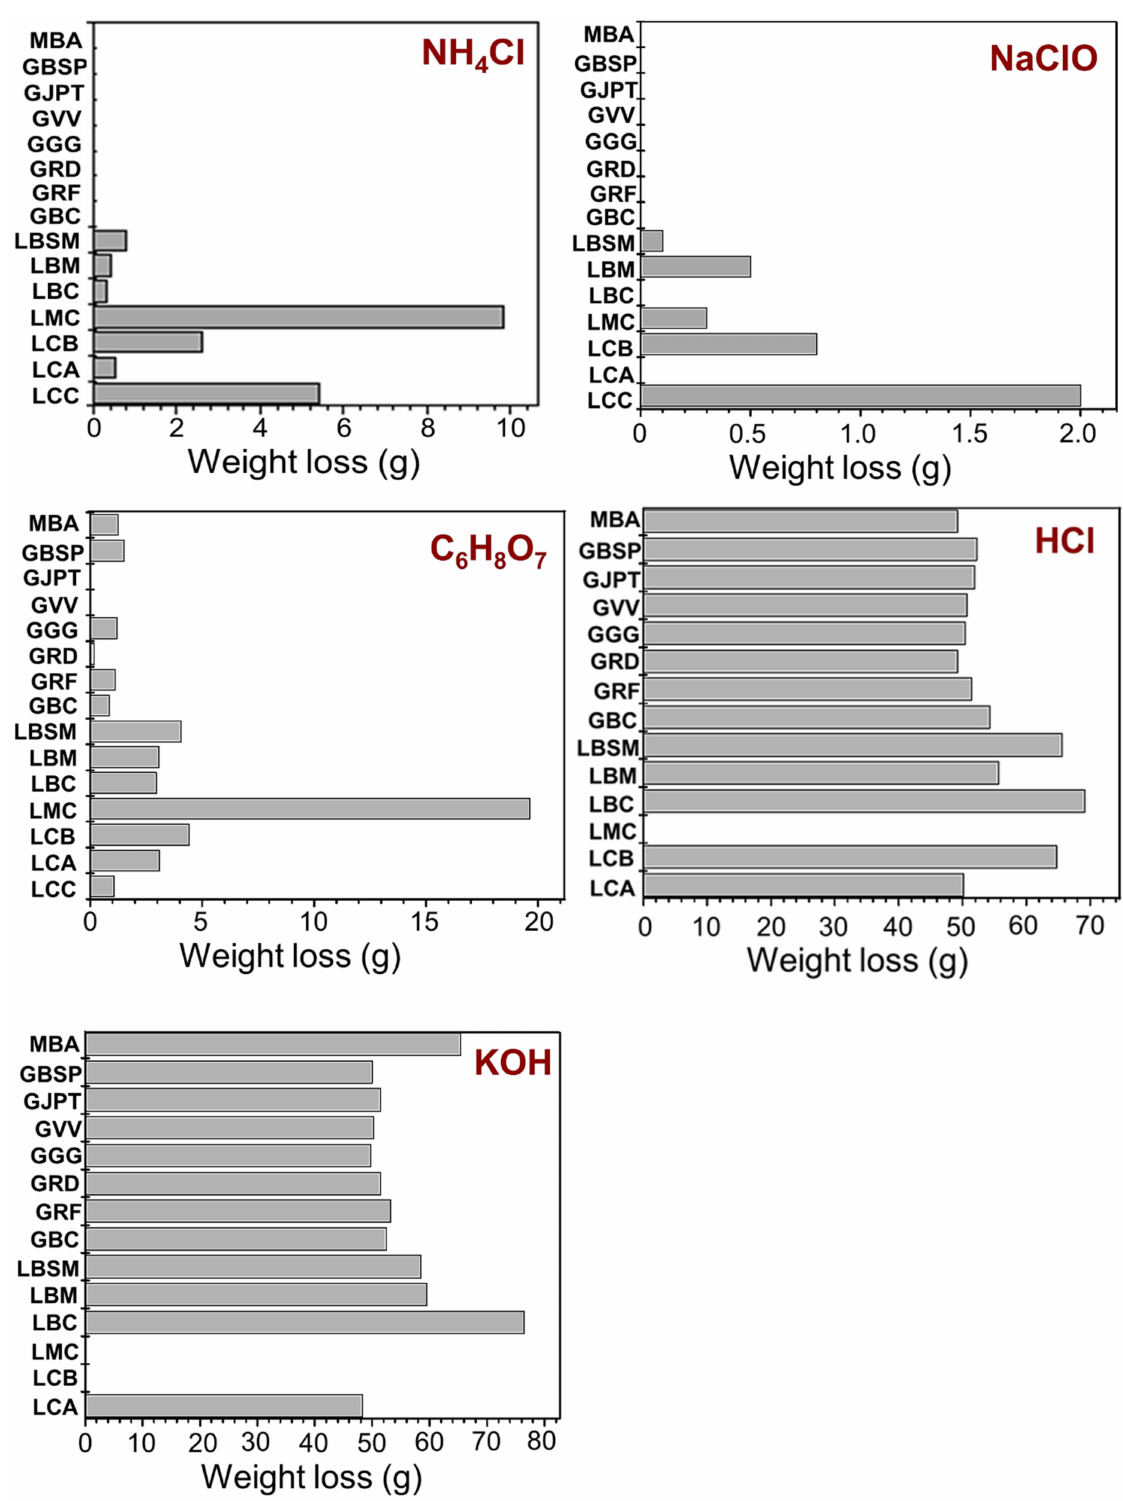
Figure 10. Loss of mass of the samples analyzed after exposure to chemical